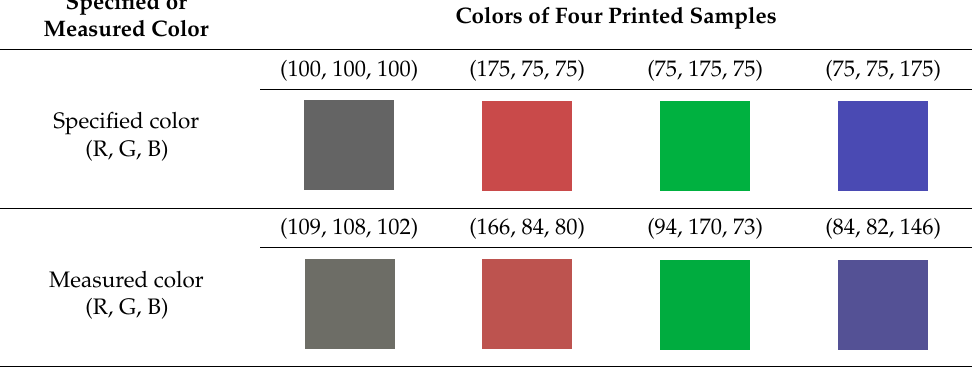
Table 1. Comparison of specified RGB values and measured RGB values.